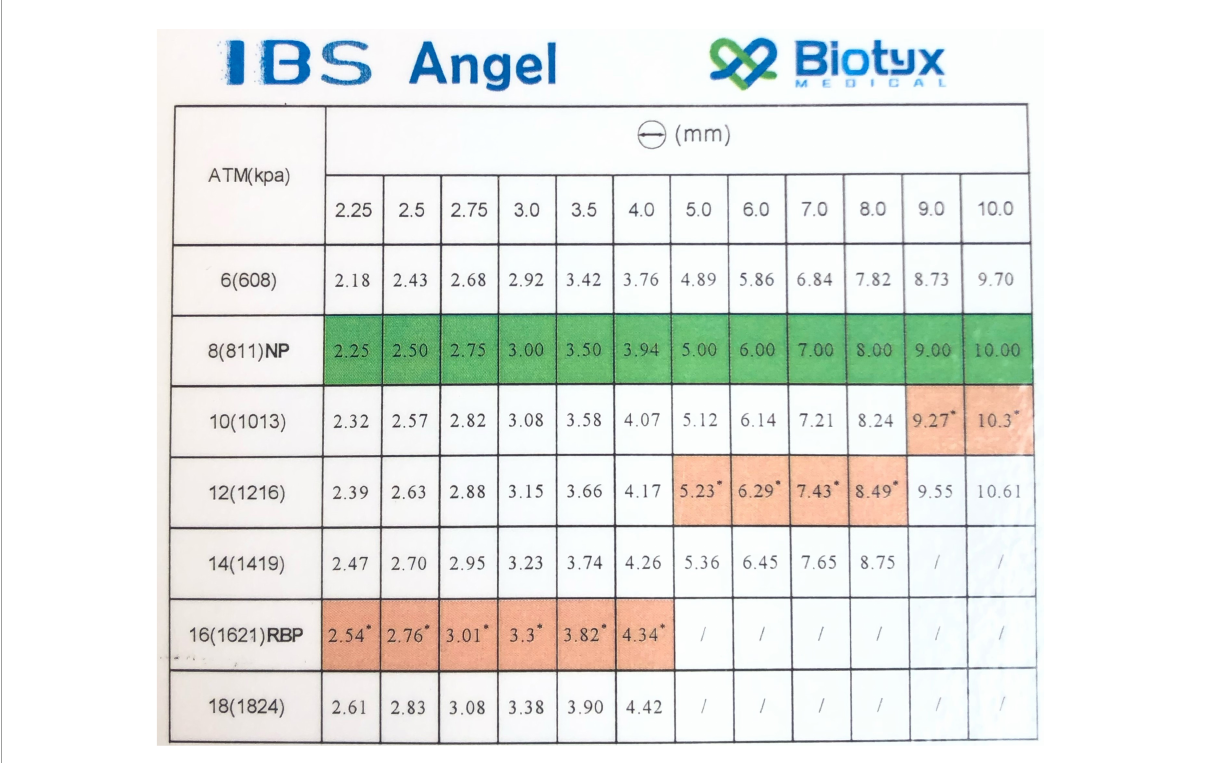
FIGURE2 IBS Angel monorail stent diameter to balloon pressure